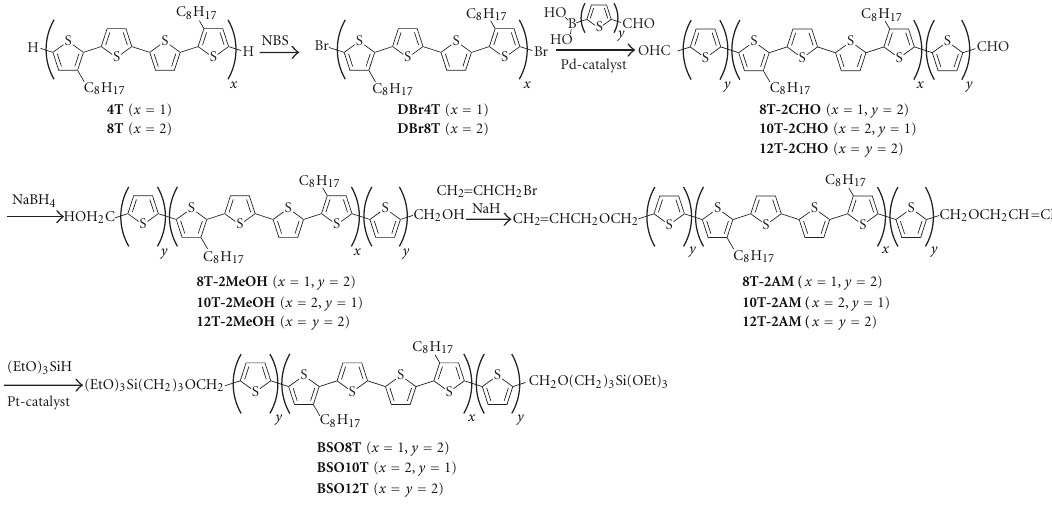
Scheme 3: Synthesis of BSO n T ( n = 8, 10, and